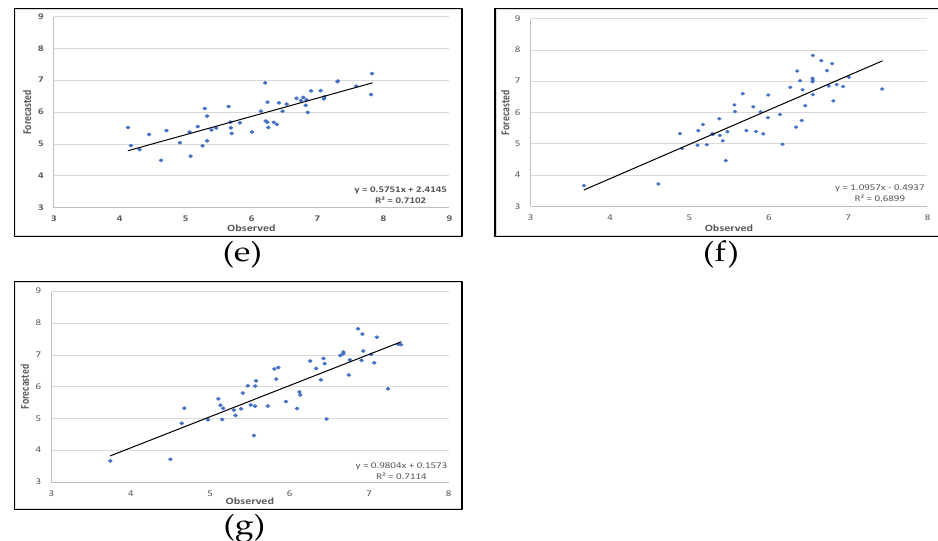
Figure 4. Scatter plots of the predictions obtained for coal energy generation (48 − month forecasts) for